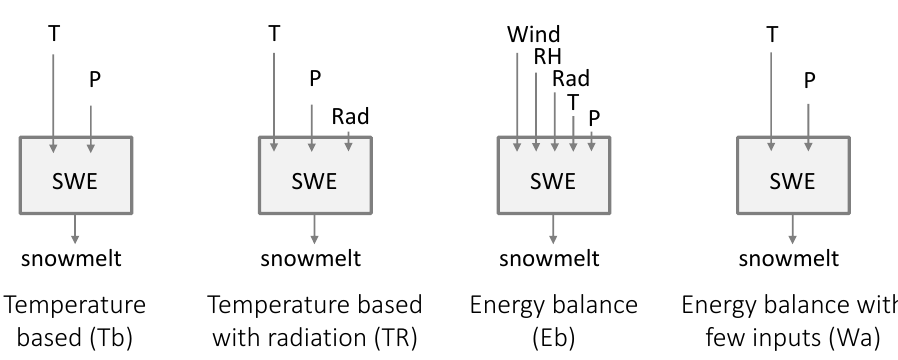
Figure 2. Sketch of the snow models specifying the time series used as input (T: temperature; P: precipitation, R: radiation; RH: relative humidity).